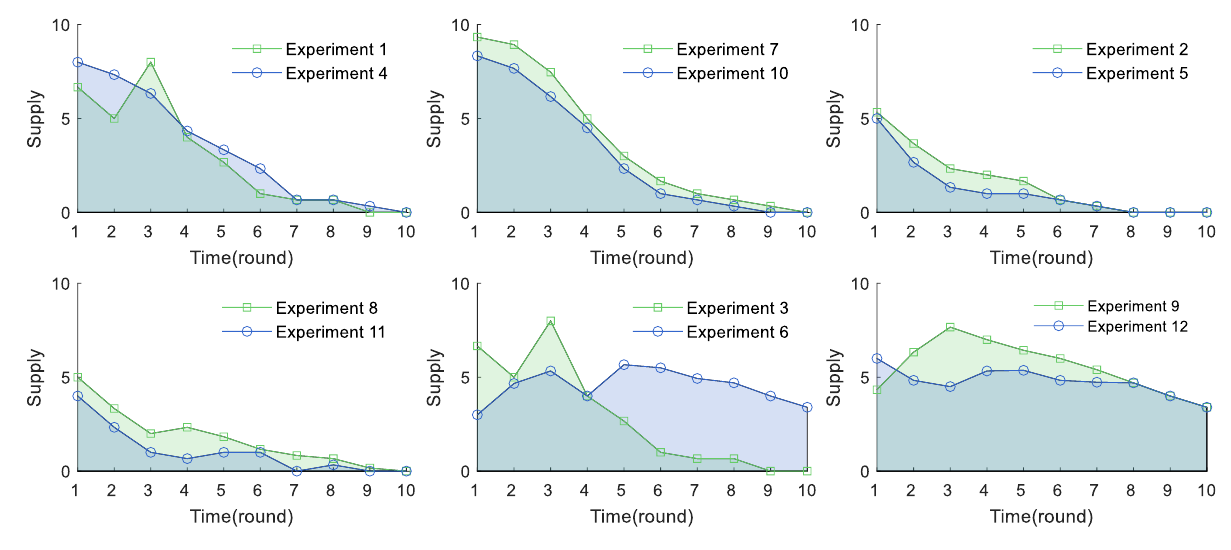
Figure 10. Effects of leadership style on supply.